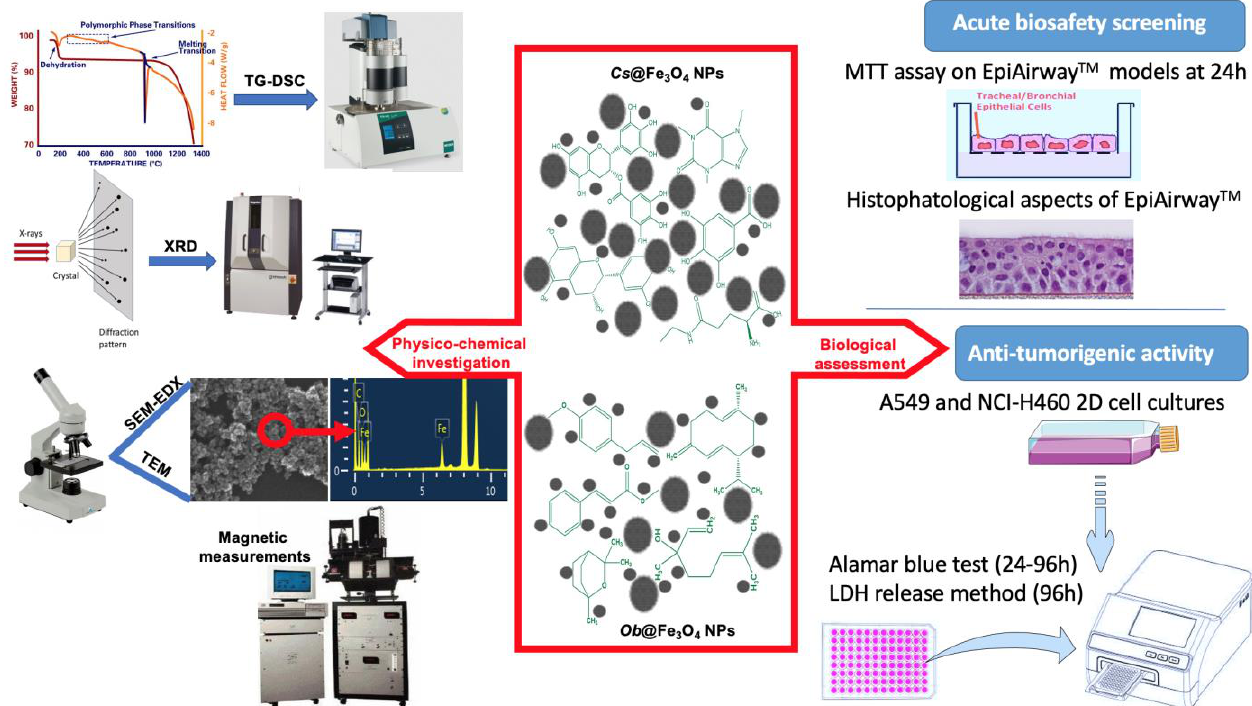
Figure 1. Schematic representation of the methodology section.